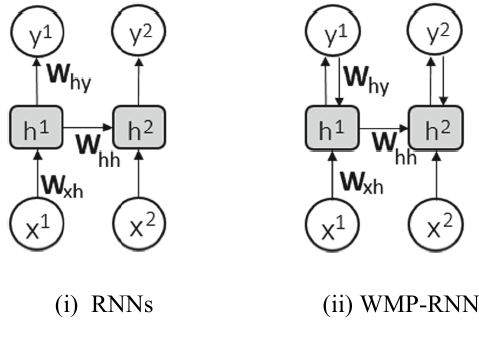
Figure 3. RNNs and WMP-RNN